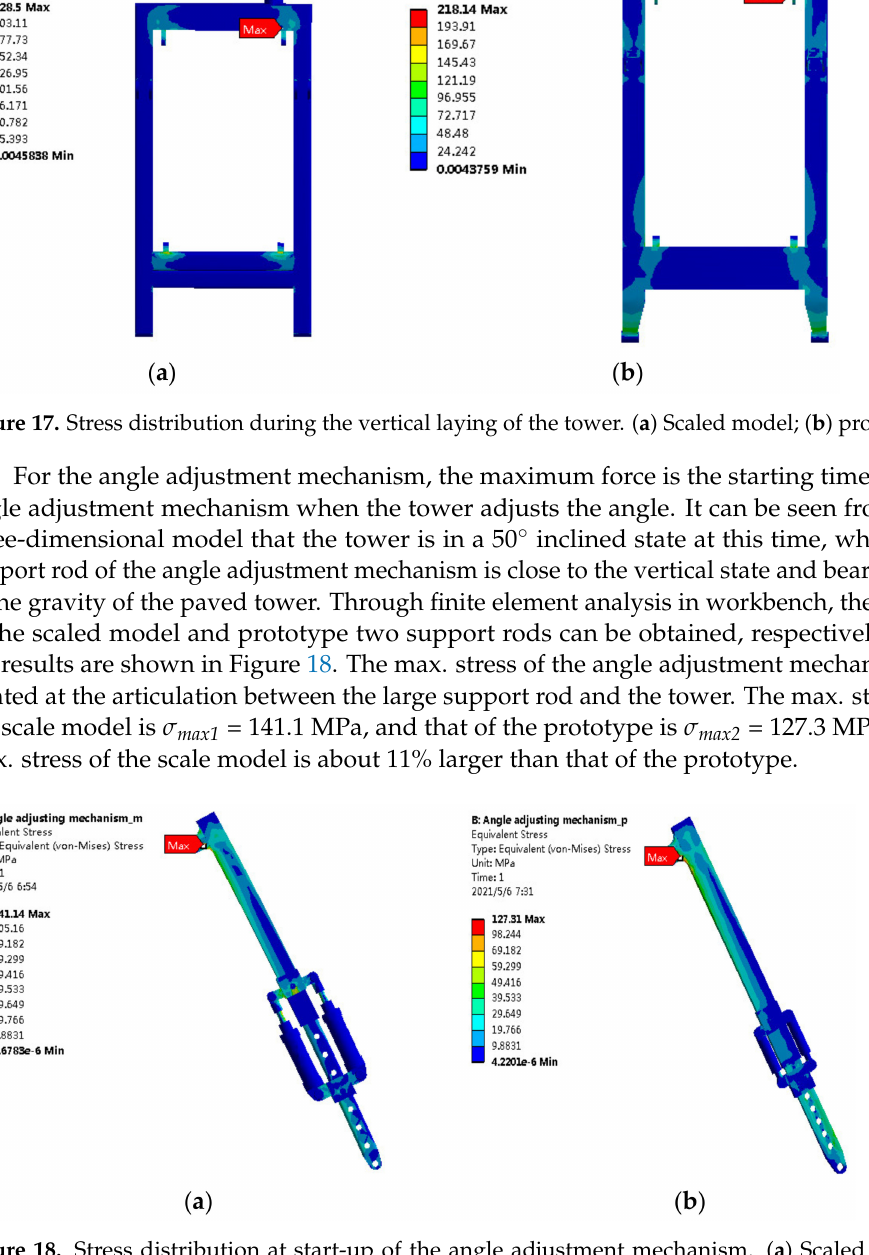
Figure 18. Stress distribution at start-up of the angle adjustment mechanism. ( a ) Scaled model; ( b )